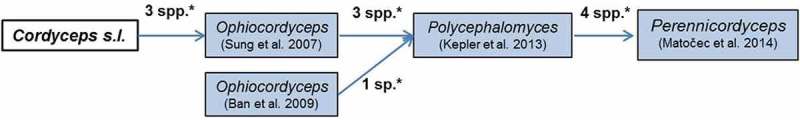
Species composition of Perennicordyceps. * indicates the no. of spp. transferred from one genus to another.